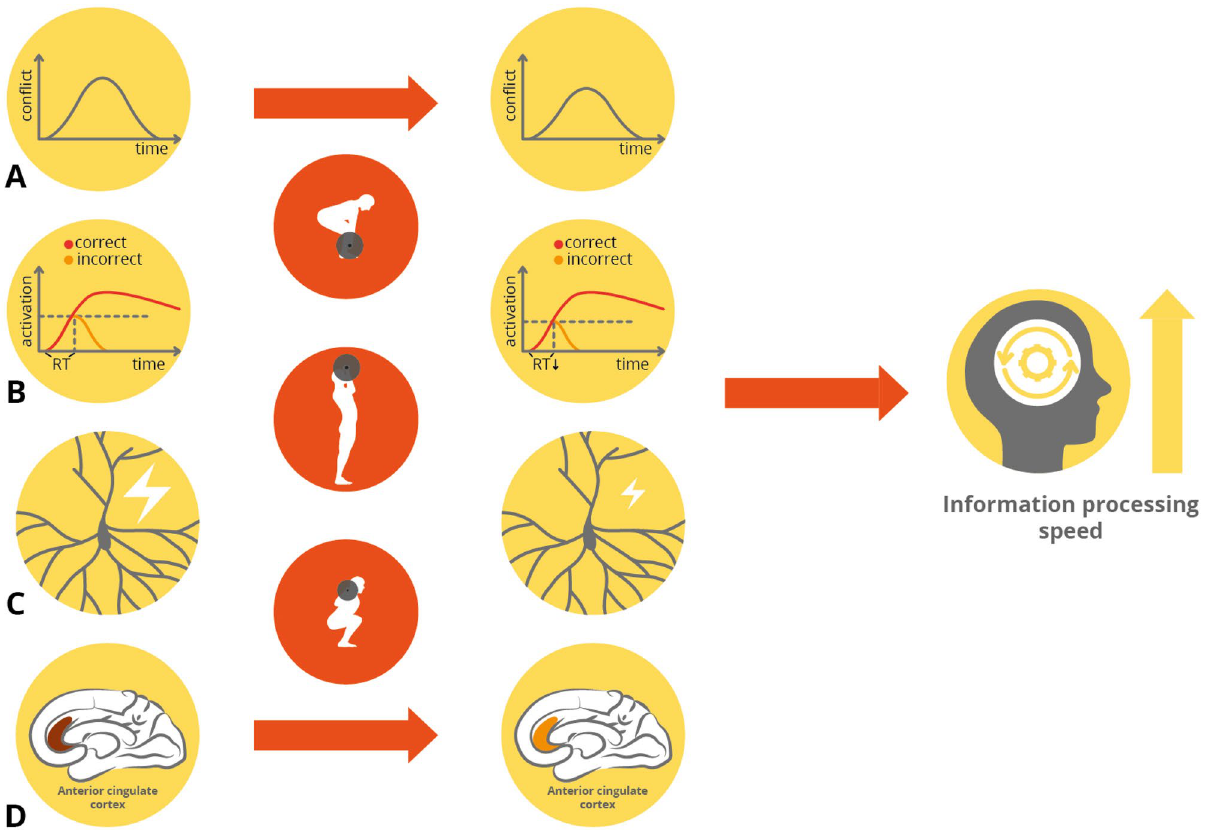
Figure 6. The potential mechanism underlying the improvement of information processing speed. ( A ) The conflict lessened as measured by the decreased N2b amplitude. ( B ) The decrease of conflict may attribute to the reduction of activation of incorrect along with a lower threshold for responses (dotted line). ( C ) and ( D ) The decrease of N2b amplitude reflects the lessened conflict in